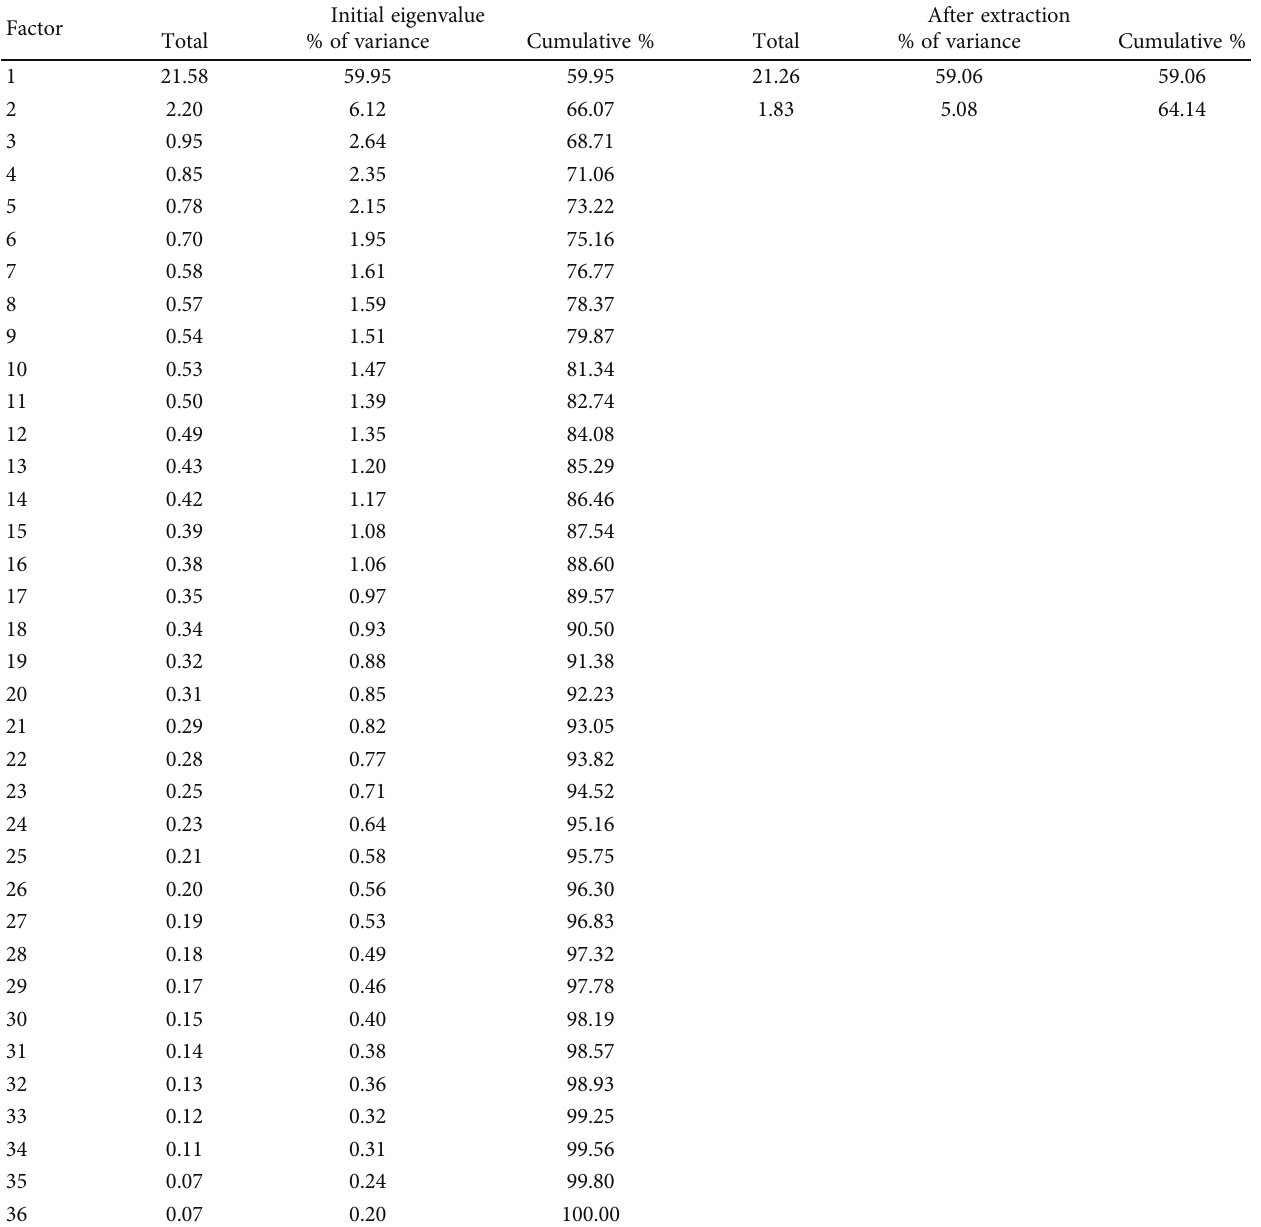
Table 2: WHQ-Ar factor